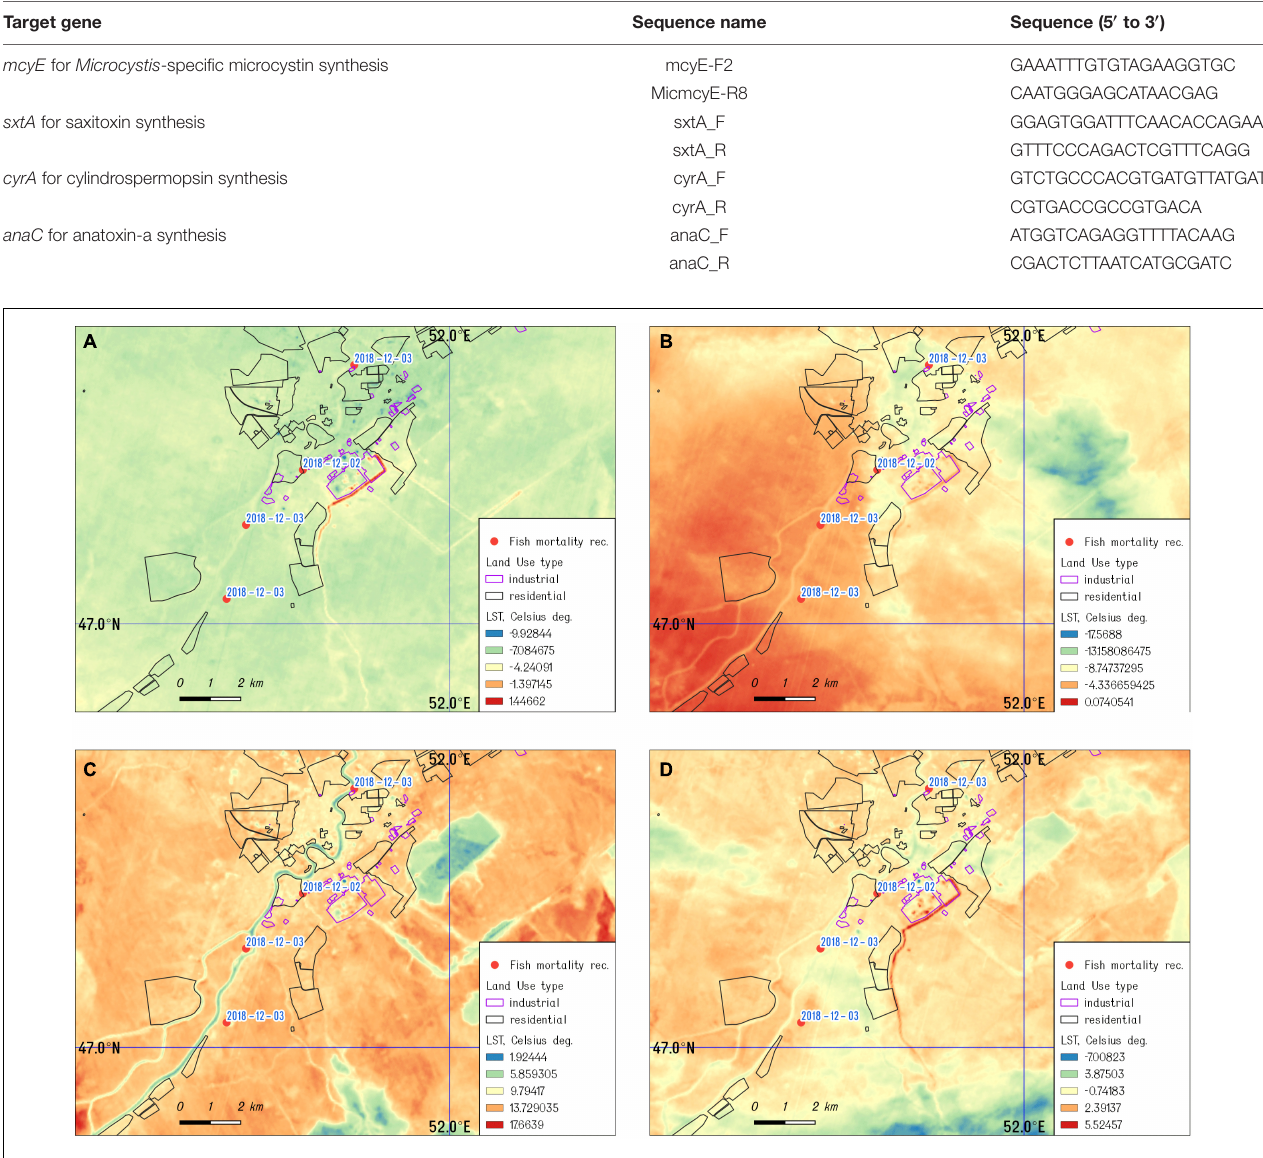
FIGURE 3 | The land surface temperature of the study area: (A) December 01, 2018; (B) December 08, 2018; (C) March 14, 2019; and (D) December 01, 2019.